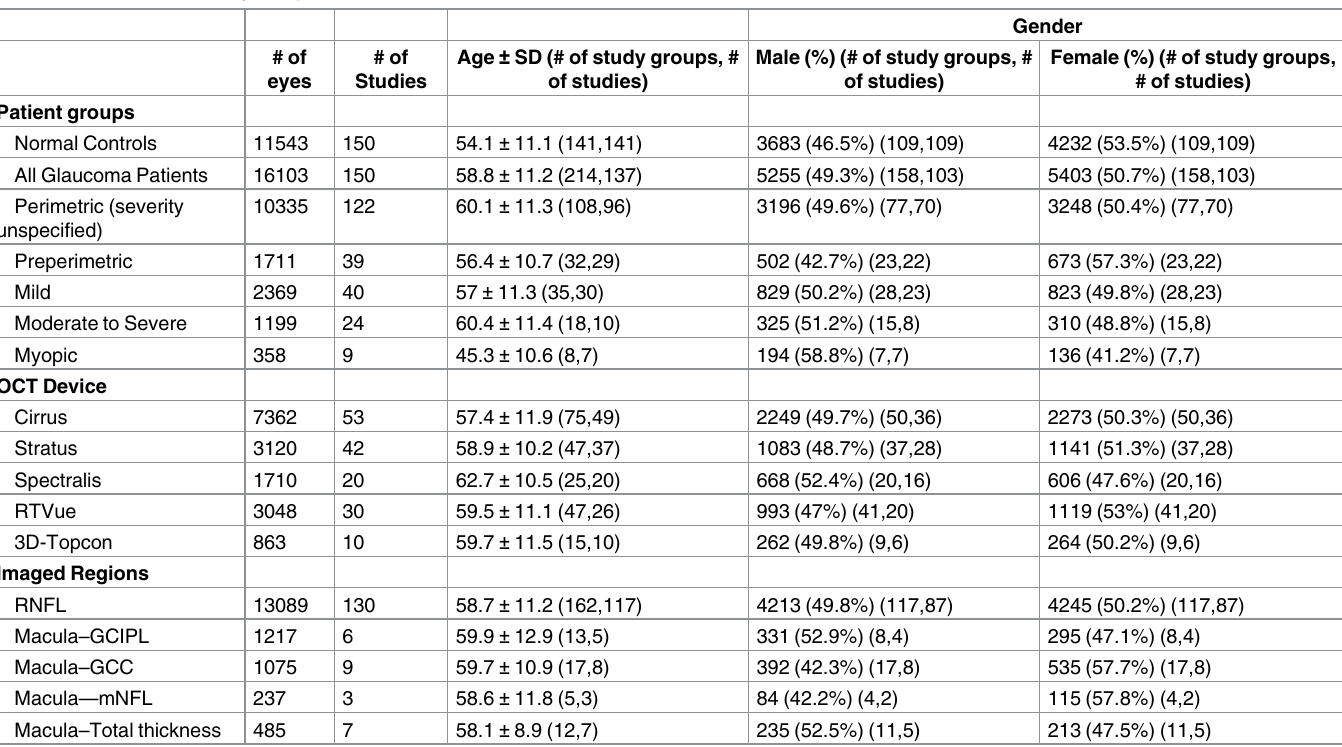
Table 1. Summarizedstudy and patient